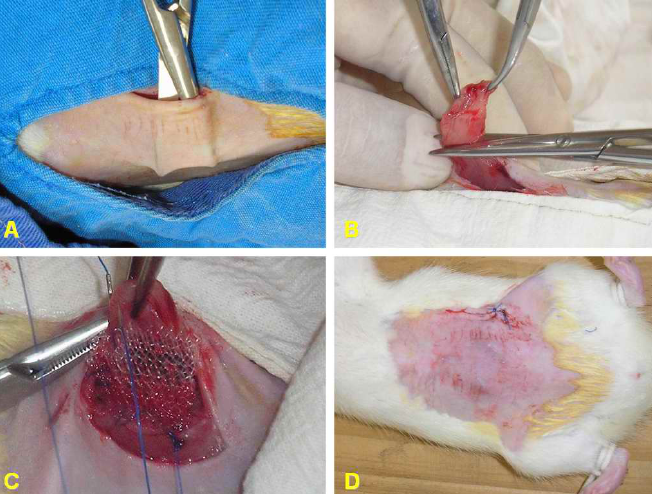
FIGURE 1 - Polypropylene mesh implant for reconstructing defect on rats abdominal wall; ( A ) Left paramedian cutaneous incision and incision and subcutaneous tunnel creation; ( B ) Defect creation by removal of right rectus abdominalis segment; ( C ) Polypropylene mesh sutured with polypropylene thread to correct the defect; ( D ) Intradermal suture aspect at the end of mesh implant